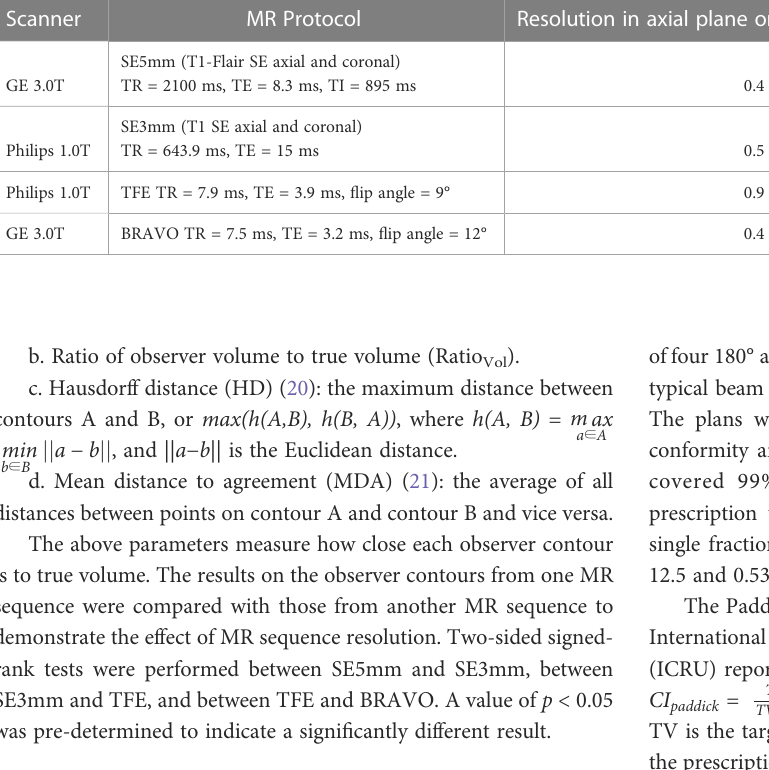
TABLE 2 MR protocols listed with increasing image resolution. Scanner MR Protocol Resolution in axial plane or plane of acquisition (mm 2 )